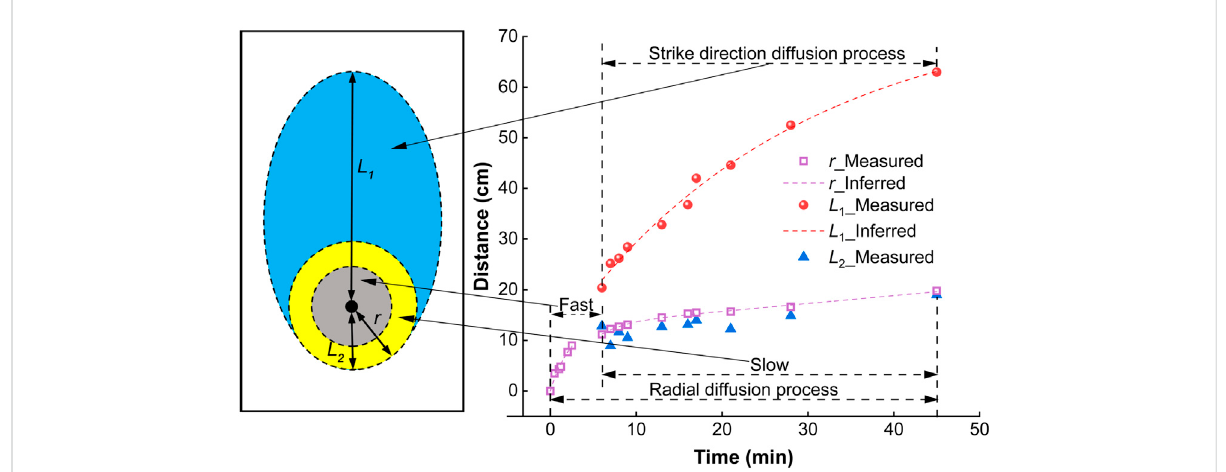
FIGURE 8 Slurrydiffusiondistance(fromthegroutingholetoslurrydiffusionboundary)vs.time.Here, r indicatestheradialdiffusionradius, L 1 indicatesthe distance from the front end of the strike diffusion boundary to the grouting hole, and L 2 indicates the distance from the front back of the strike diffusion boundary to the grouting hole.